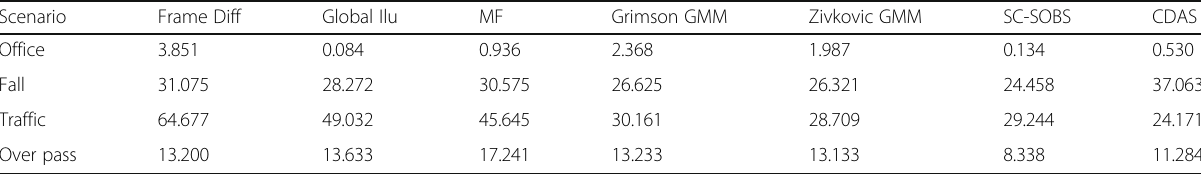
Table 8 Comparisons of PWC of the competing methods over tested scenarios Scenario